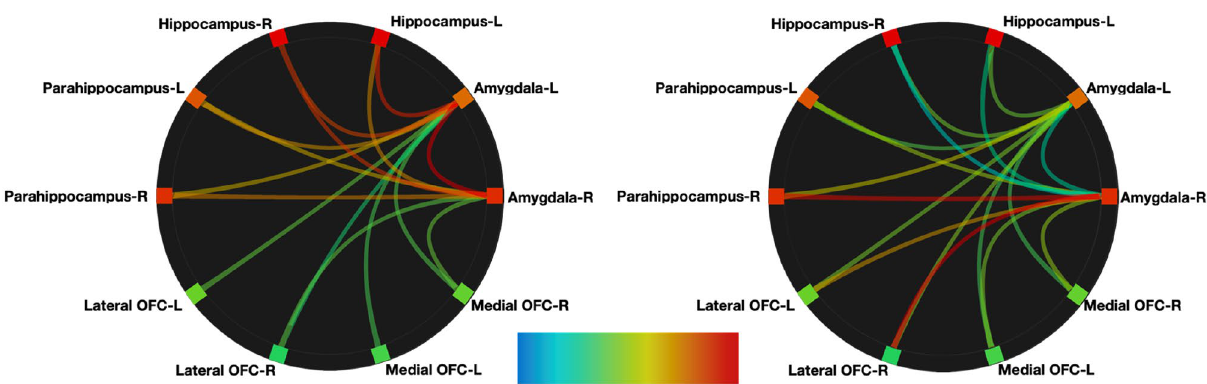
Figure 3. Connectome rings showing relative intrinsic connectivity between the anatomical ROIs of the bilateral amygdala to bilateral hippocampus and parahippocampal gyri and the left lateral and right medial OFC-orbitofrontal cortices. Color and thickness of path indicates strength of the connectivity with red being the strongest and blue weakest (unthresholded). Left: VIP-independent intrinsic connectivity. Right: VIP-associated connectivity controlling for anxiety and